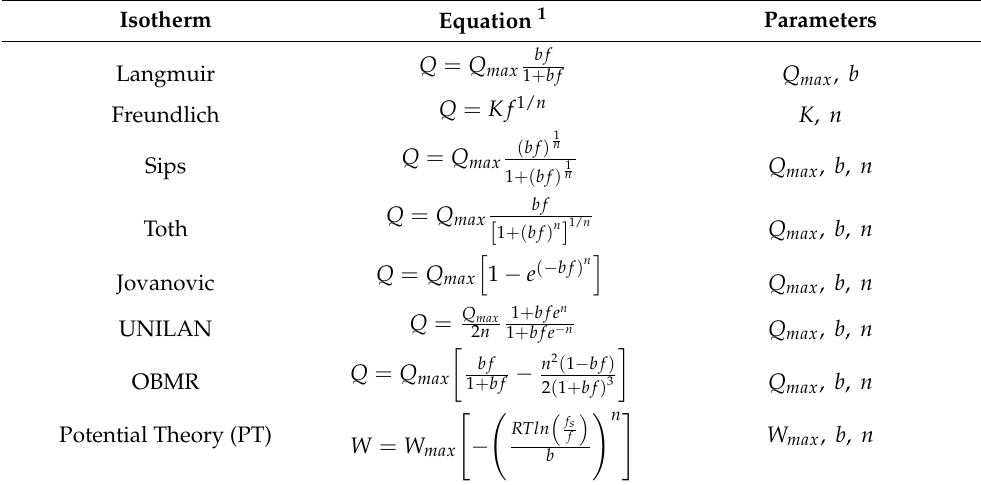
Table 1. Adsorption modelling equations and associated